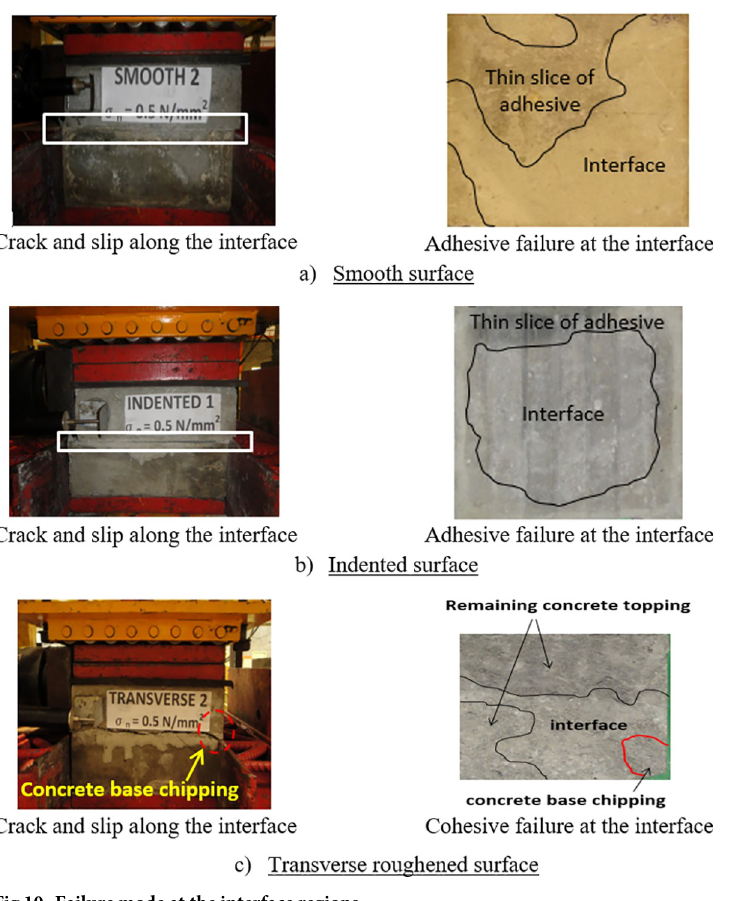
Fig 10. Failure mode at the interface